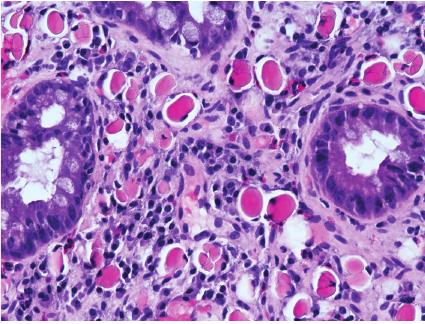
Figure 2: Hematoxylin and eosin , 20x . Biopsies from the Barrett mucosa showed intestinal metaplasia with active inflammation and numerous monomorphic cells in the lamina propria with eccentric nuclei and abundant eosinophilic cytoplasm.